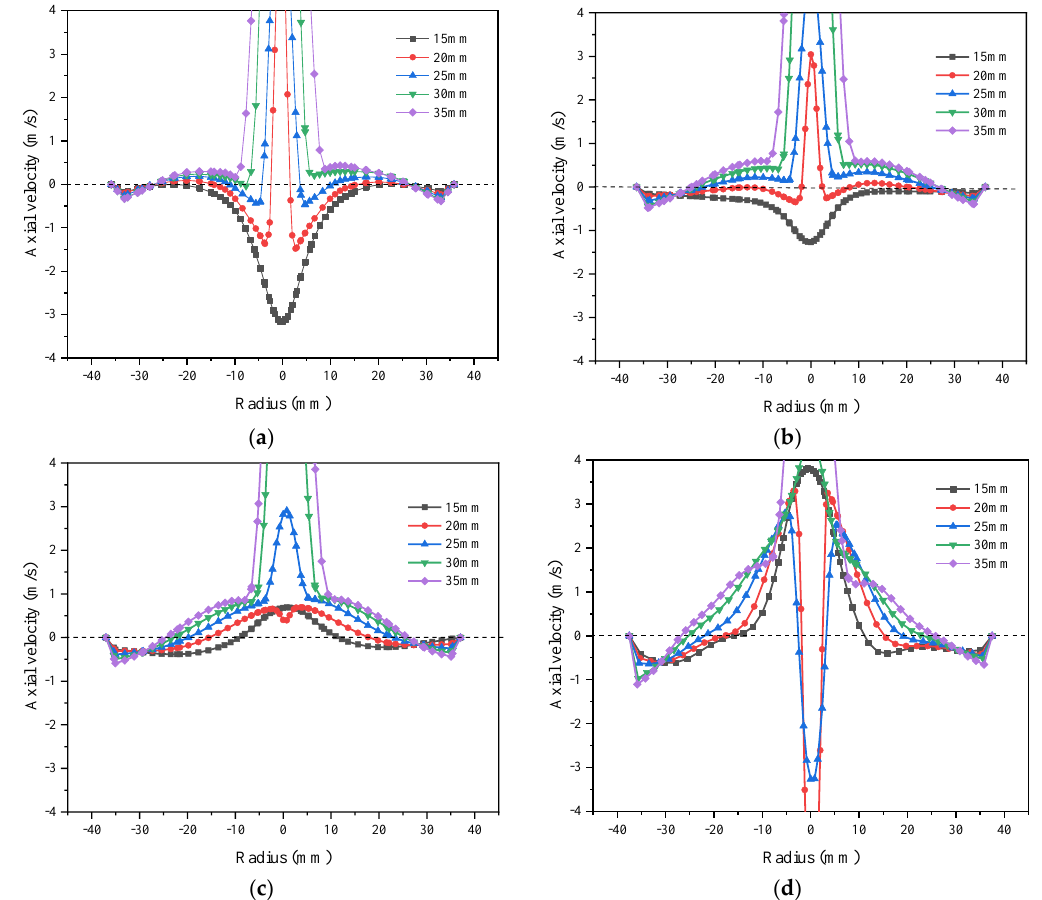
Figure 13. The axial velocity: ( a ) Z = 75 ( b ) Z = 100; ( c ) Z = 125; ( d ) Z = 175.